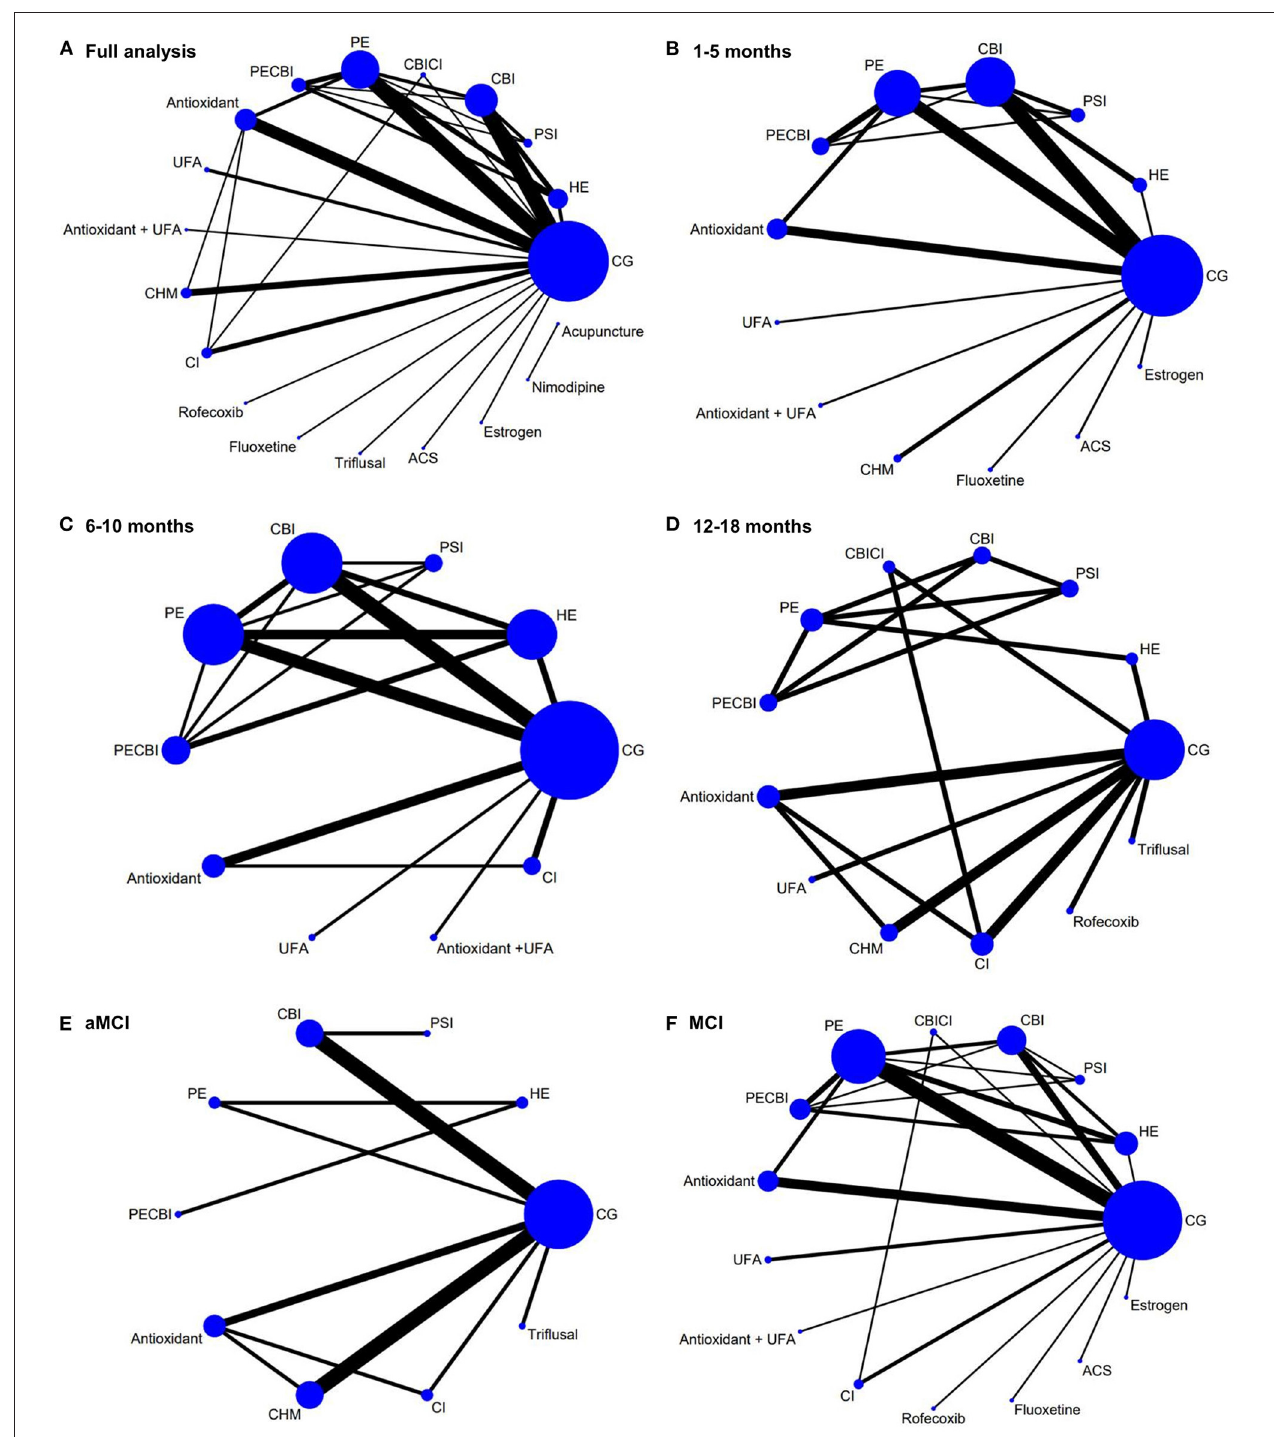
FIGURE 2 | Network plot of included studies and subgroup analysis. (A) Network plot of the full analysis. (B) Network plot of the subgroup analysis in studies with a follow-up period of 1–5 months. (C) Network plot of the subgroup analysis in studies with a follow-up period of 6–10 months. (D) Network plot of the subgroup analysis in studies with a follow-up period of 12–18 months. (E) Network plot of the subgroup analysis in aMCI patients. (F) Network plot of the subgroup analysis in general MCI patients. The nodes represented different intervention types, the size of which represented the number of participants in the intervention. Each line connecting two nodes represented direct comparisons between different interventions, with the thickness representing the number of studies involving in each comparison. ACS, anserine/carnosine supplementation; CBI, cognition-based intervention; CBICI, cognition-based intervention and cholinesterase inhibitor; CG, control group; CHM, Chinese herbal medicine; CI, Cholinesterase inhibitor; HE, health education; PE, physical exercise; PECBI, physical exercise and cognition-based intervention; PSI, psychosocial intervention; UFA, unsaturated fatty acid.